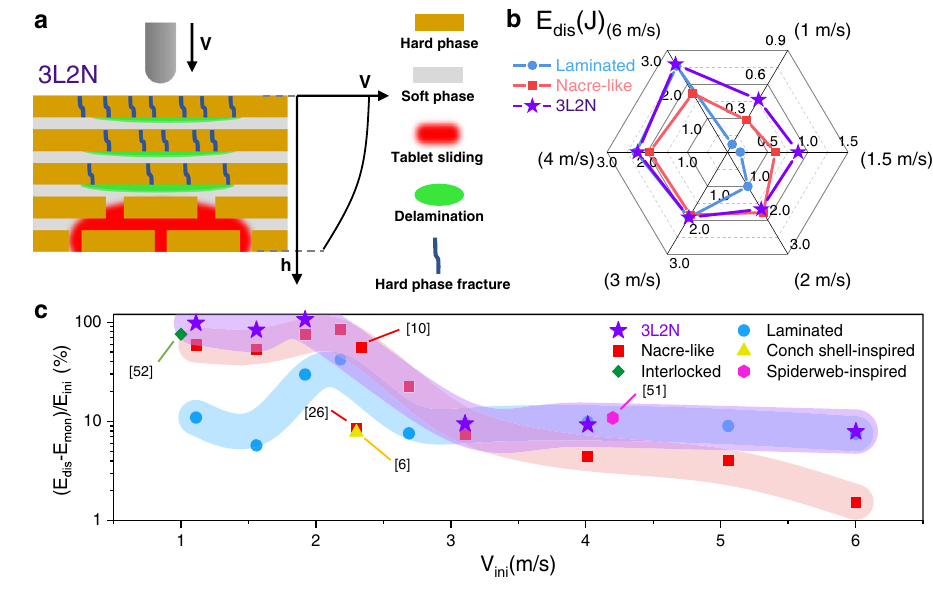
Fig. 6 | Hybrid architectural panel design. a Schematic of the hybrid archi- tecture ’ s design considering the impact velocity distribution along the cross- sectionofpanel,where3L2Nrepresentsthreelayersofthelaminatedstructureand two layers of the nacre-like structure. b Energy dissipation E dis of the laminated samples, the nacre-like samples and the 3L2N samples under different impact